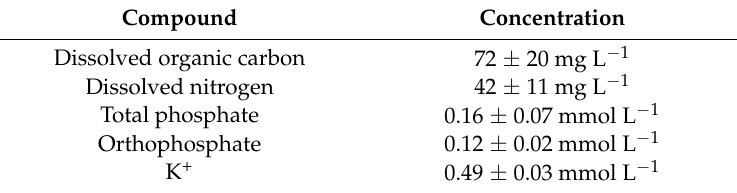
Table 1. Major composition of EPS (extracellular polymeric substances) solution extracted from S.